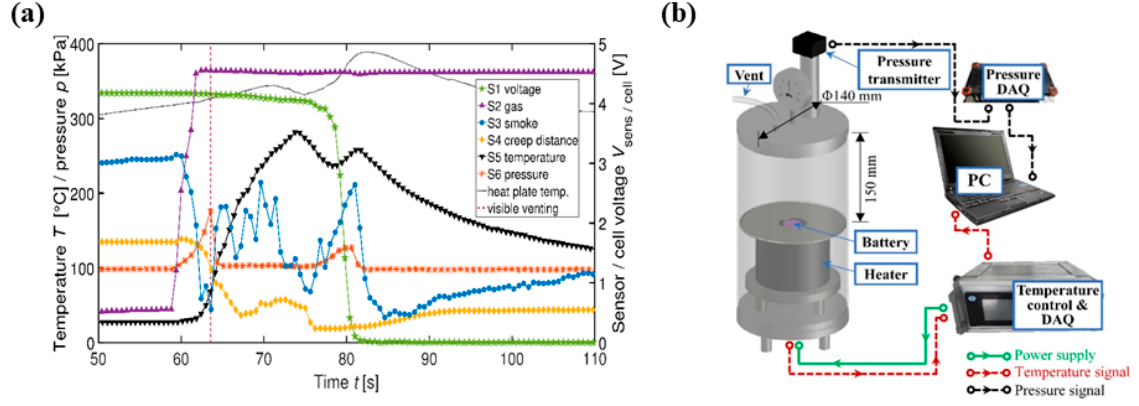
Figure 5. Through the shock pressure to detect TR: ( a ) multiple sensors detect TR of ba tt ery [88]; ( b ) experimental device for the TR shock pressure [89]. ( b ) experimental device for the TR shock pressure